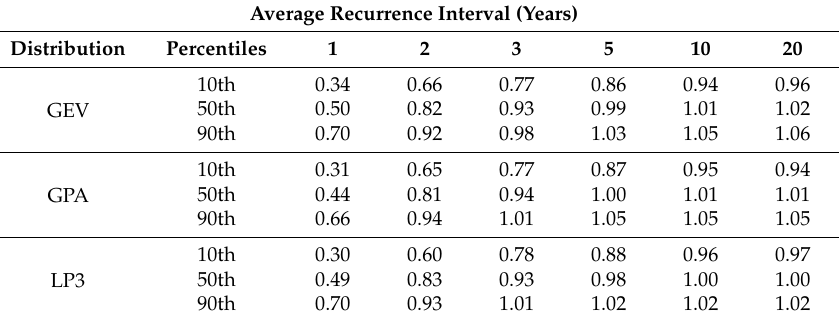
Table 6. Ratio of flood magnitudes between AM and BF series for the three best fit frequency models: Generalised Extreme Value (GEV), GPA and Log Pearson 3 (LP3). Data presented here are the average of 24 gauging sites across the study